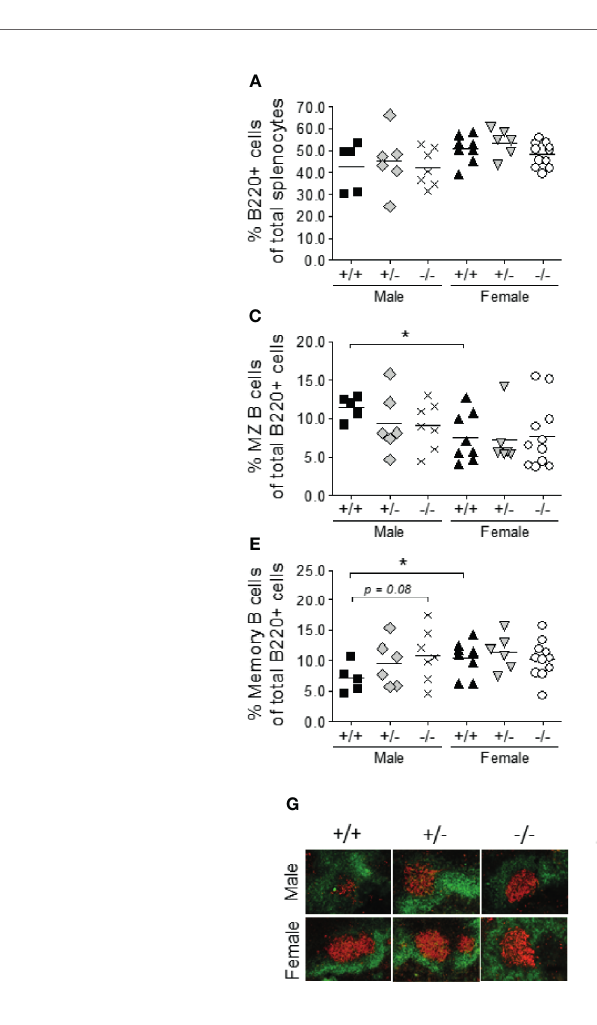
FIGURE 4 | S100a9- de fi ciency results in increased spontaneous germinal reactions in male BWF1 mice. Spleens were harvested from eight month old BWF1 lupus- prone mice and percentages of B cell subsets were determined by fl ow cytometry: (A) total B220+ cells, (B) Follicular mature (B220 + CD23 high CD21 low IgM low ) B cells, (C) Marginal Zone B cells (B220 + CD21 high CD23 low IgM high ), (D) Germinal center B cells (B220 + GL7 + CD38 low IgM low ), (E) memory B cells (B220 + CD38 high GL7 - IgM - ) and (F) Plasma cells (B220 -/low CD138 + IgM - IgD - ). G) Frozen spleen sections were stained for B cells (B220-FITC) and germinal centers (GL-7-TexasRed). Representative pictures are shown. H) Germinal center areas from (G) were determined using the Keyence BZ-X analysis software. (A – F, H) Each symbol represents one individual mouse ( n = 5-11). *p < 0.05; **p < 0.01, Student ’ s unpaired t test with Welch ’ s correction. One-way ANOVA: p = 0.13 (A) , p = 0.14 (B) , p = 0.33 (C) , p < 0.01 (D) , p = 0.36 (E) , p < 0.01 (F) , p < 0.01 (H)